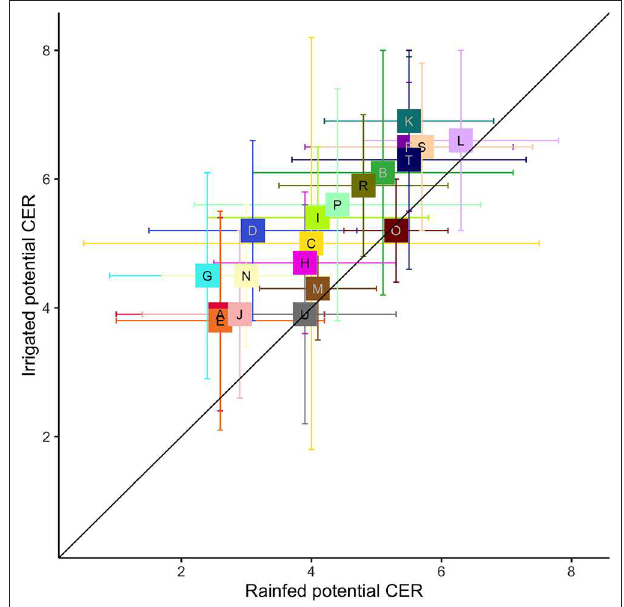
FIGURE 7 | The 90th percentile of maximum CER predicted by irrigated and rainfed RF models for the contiguous US. Values are mean and standard deviation for each LRR, following the colors and letter code given in Figure 1 and Table 1 .